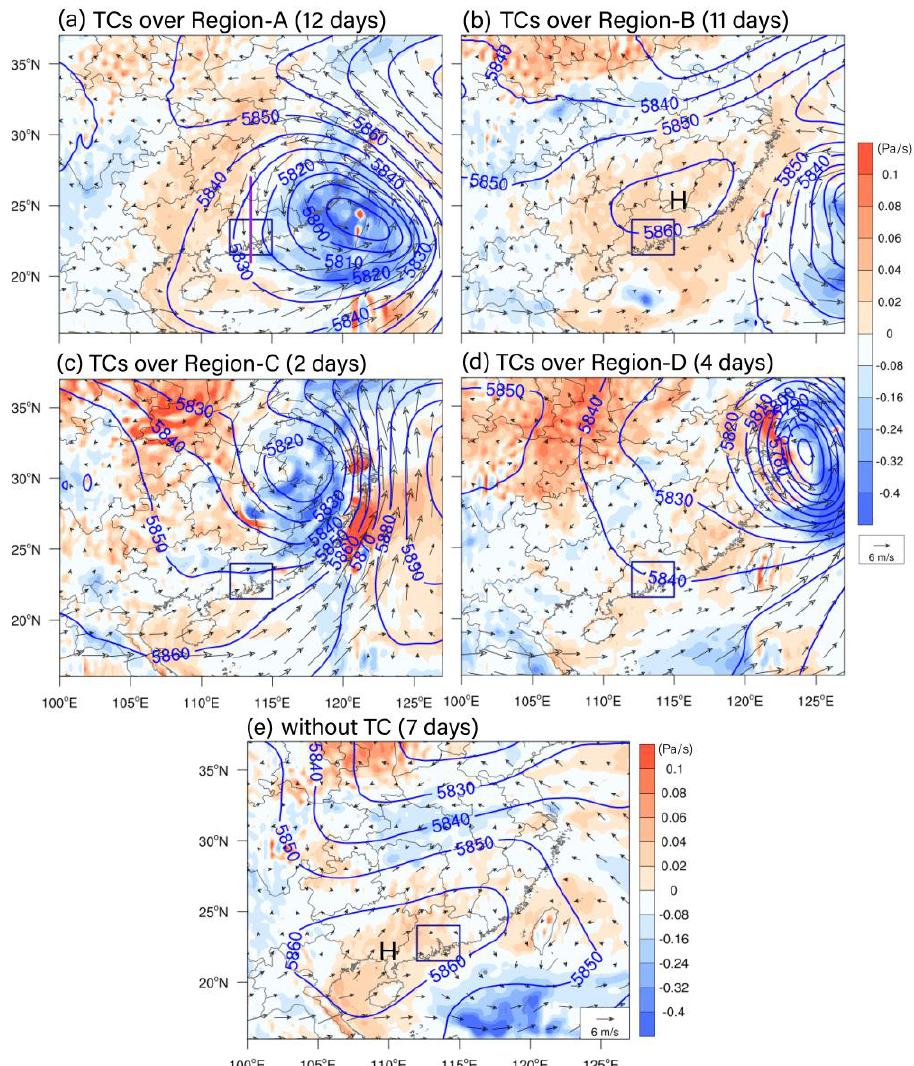
Figure 8. Synthetic fields for the five subgroups of the PRD-only heatwave days: ( a – e ) with TCs centered over Regions A, B, C, and D as shown in Figure 7 and I without TC, including 500 hPa geopotential height (blue contours; unit: gpm) and vertical velocity (shadings), and 850 hPa horizontal wind vectors (arrows). Thick purple line in ( a ) represents the location of vertical cross-section used in Figure 9. Rectangular box in each panel denotes the PRD region. Gray lines show the national and provincial boundaries and coastlines.